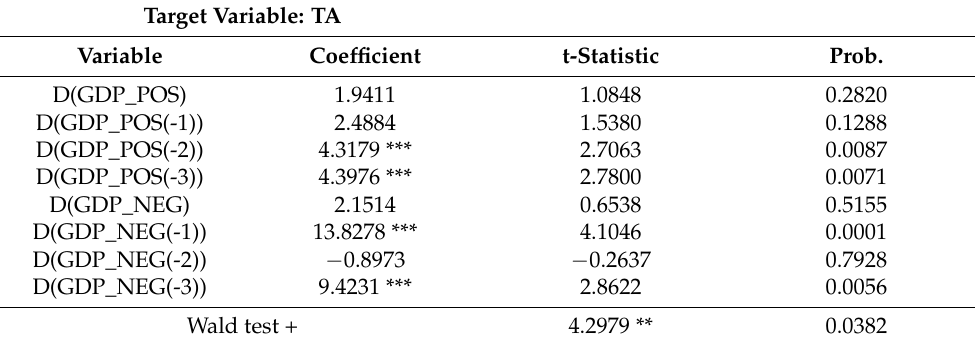
Table 7. Short-run asymmetric causality test results. Target Variable: